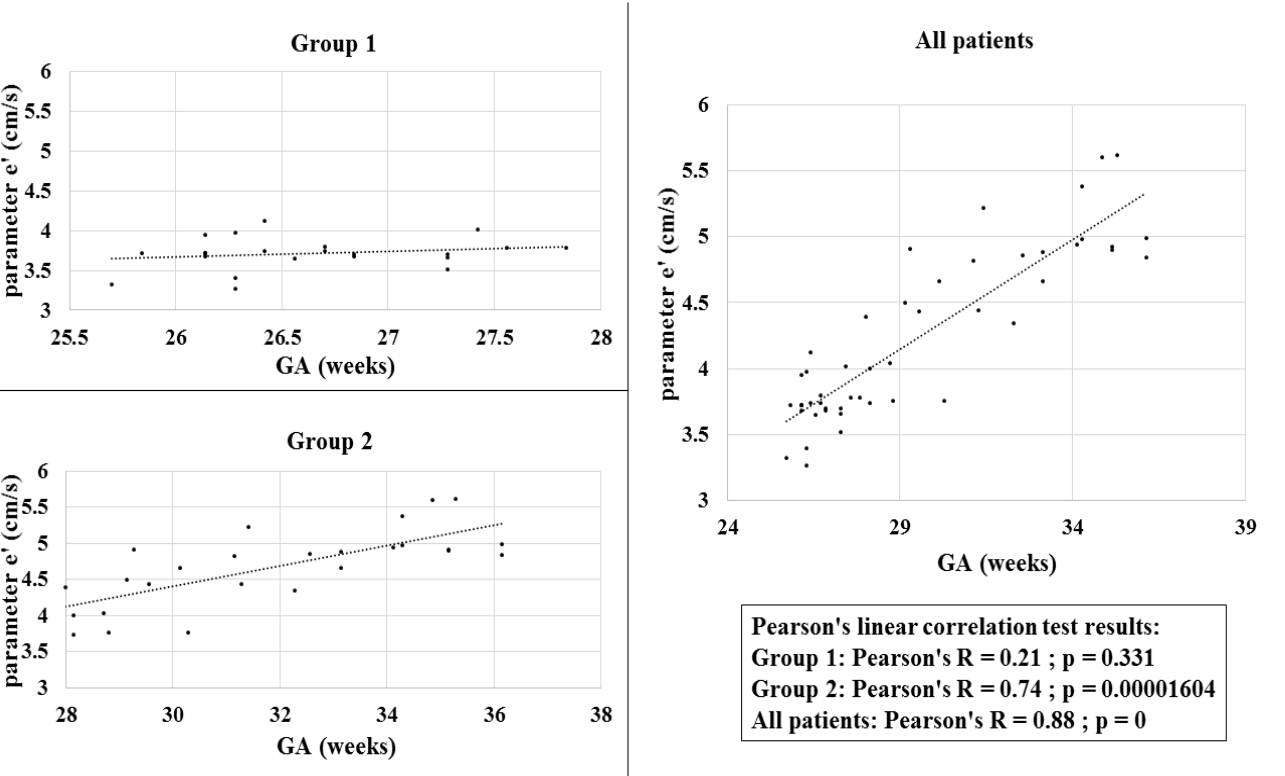
Figure 1. Correlation of parameter e’ and gestational age. Legend: GA—gestational age; parameter e’—velocity of the mitral annulus in early diastole.